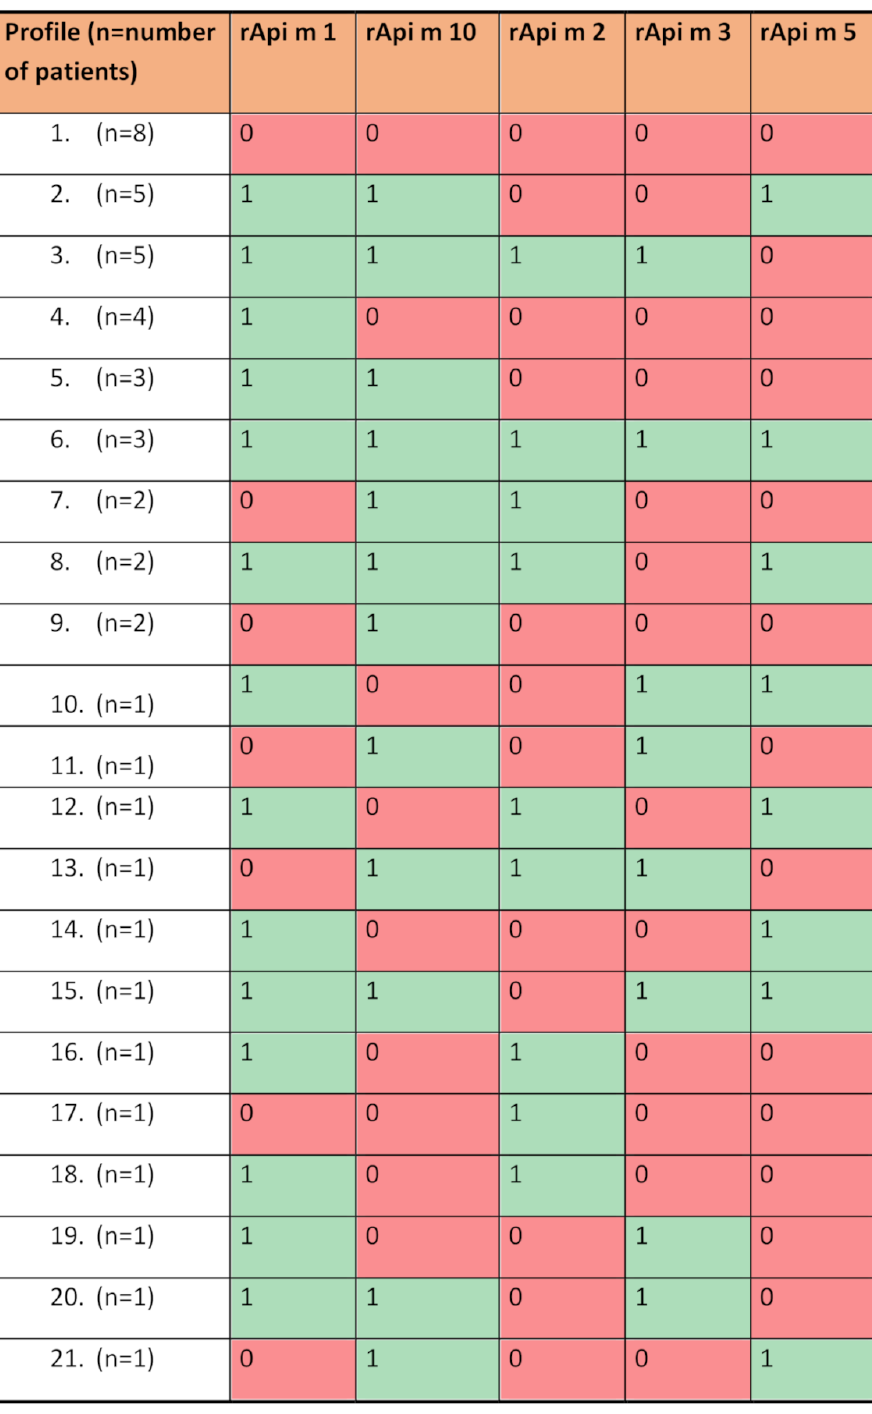
Figure 1. Profile of allergies to molecules of bee venom Api m 1, 2, 3, 5, and 10 in the group of patients allergic to bee venom (N = 46). 1—presence of allergy; 0—no